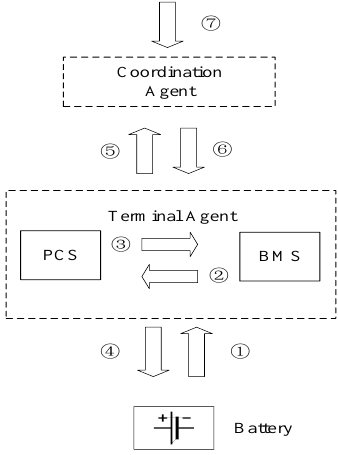
Figure 7. Multi-energy storage agent collaborative control logic.